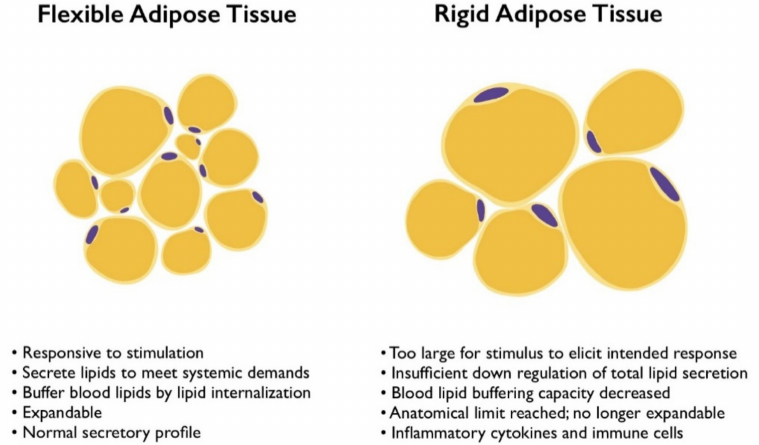
Figure 3. Characteristics of flexible and rigid adipose tissue phenotypes. Adipocyte size is a determi- nant of lipid-buffering function and responsiveness to